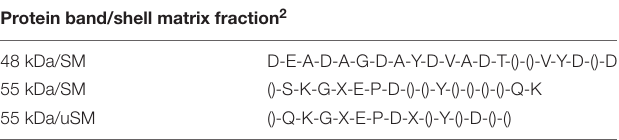
TABLE 2 | Amino-terminal sequences for the 48 and 55 kDa bands 1 . Protein band/shell matrix fraction 2